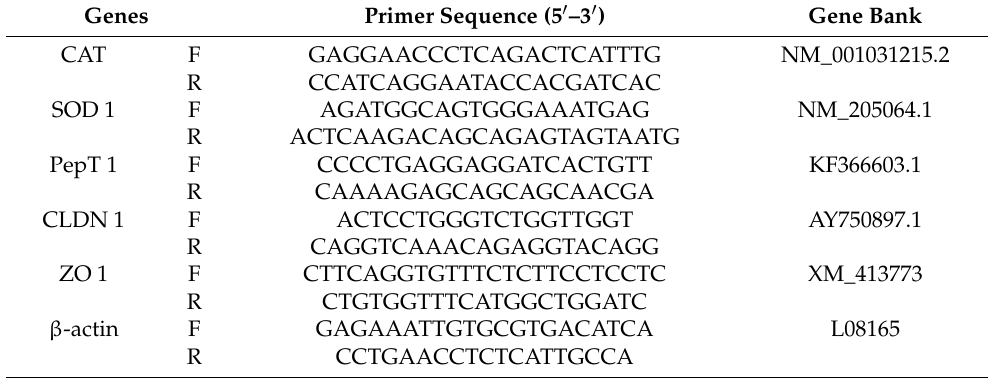
Table 1. Primers used in this experiment for the assessment of mRNA expression levels. Genes Primer Sequence (5 (cid:48) –3 (cid:48) )